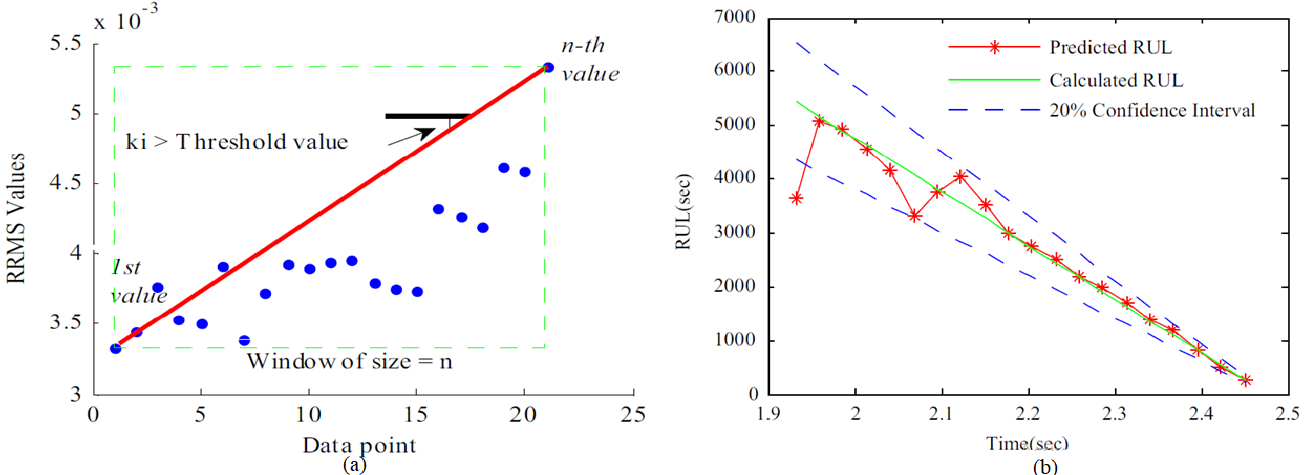
Figure 52. ( a ) Short-term degradation results for bearing faults prediction. ( b ) Performance of the proposed diagnostic methodology for forecasting of remaining useful life (RUL) [129].